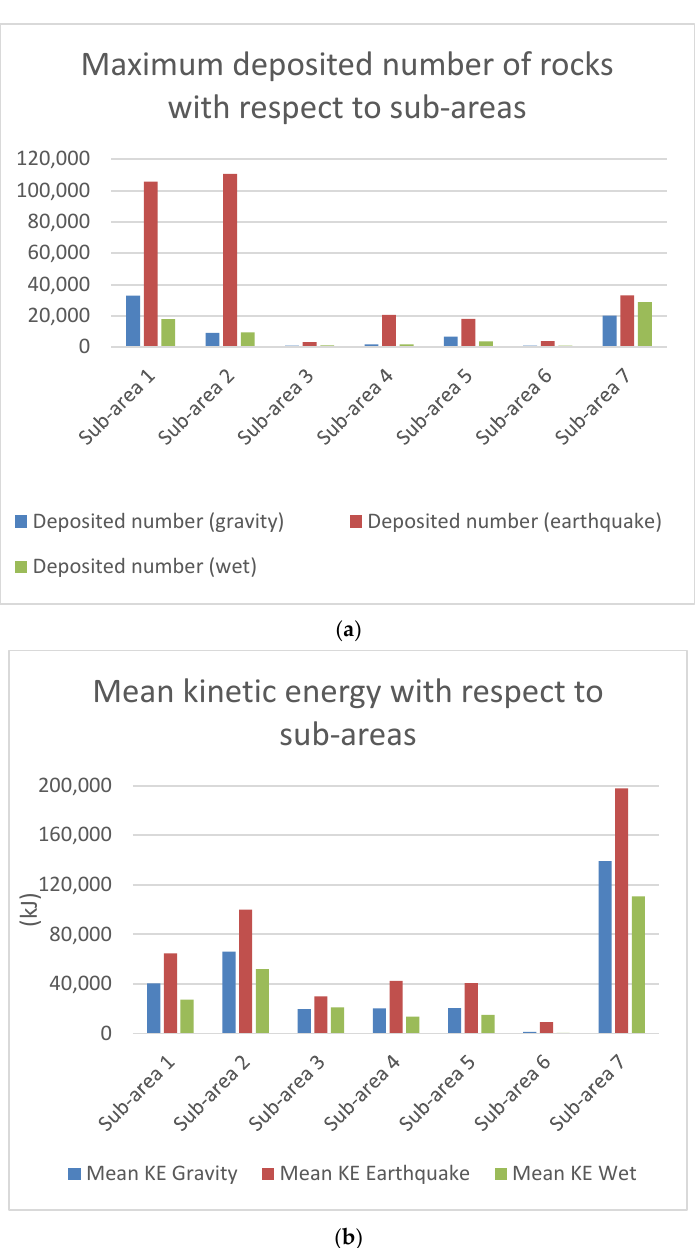
Figure 13. ( a ) Maximum deposited number of rocks with respect to sub-areas; ( b ) mean kinetic energy with respect to sub-areas.